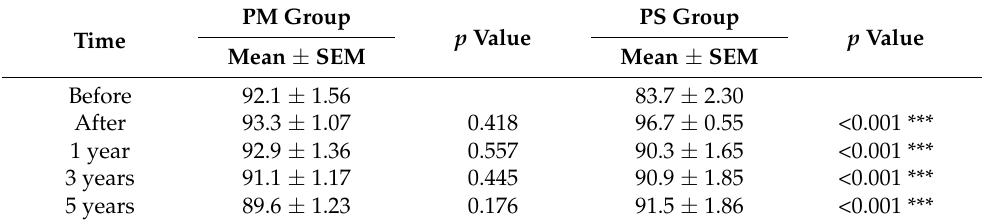
Table 6. Mean r-BIIC percentage of the PM and PS groups.